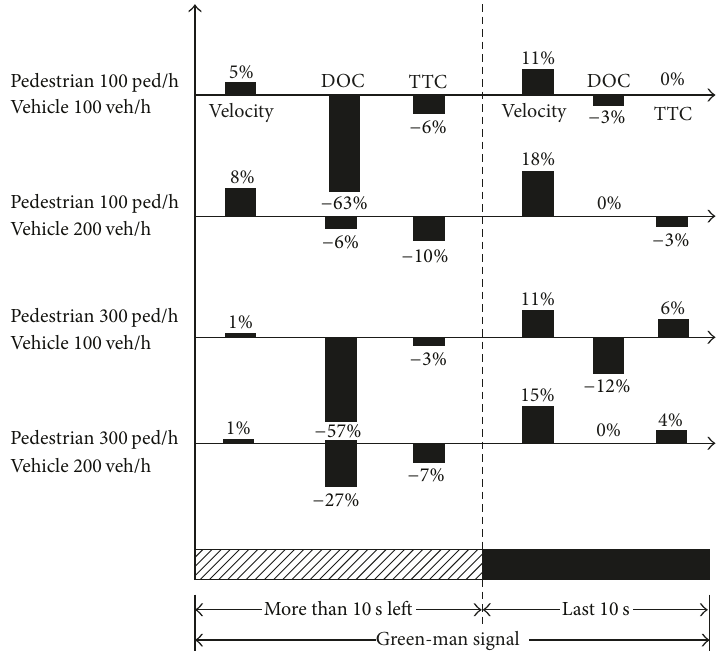
Figure 8: Impact of GMCD for each simulation